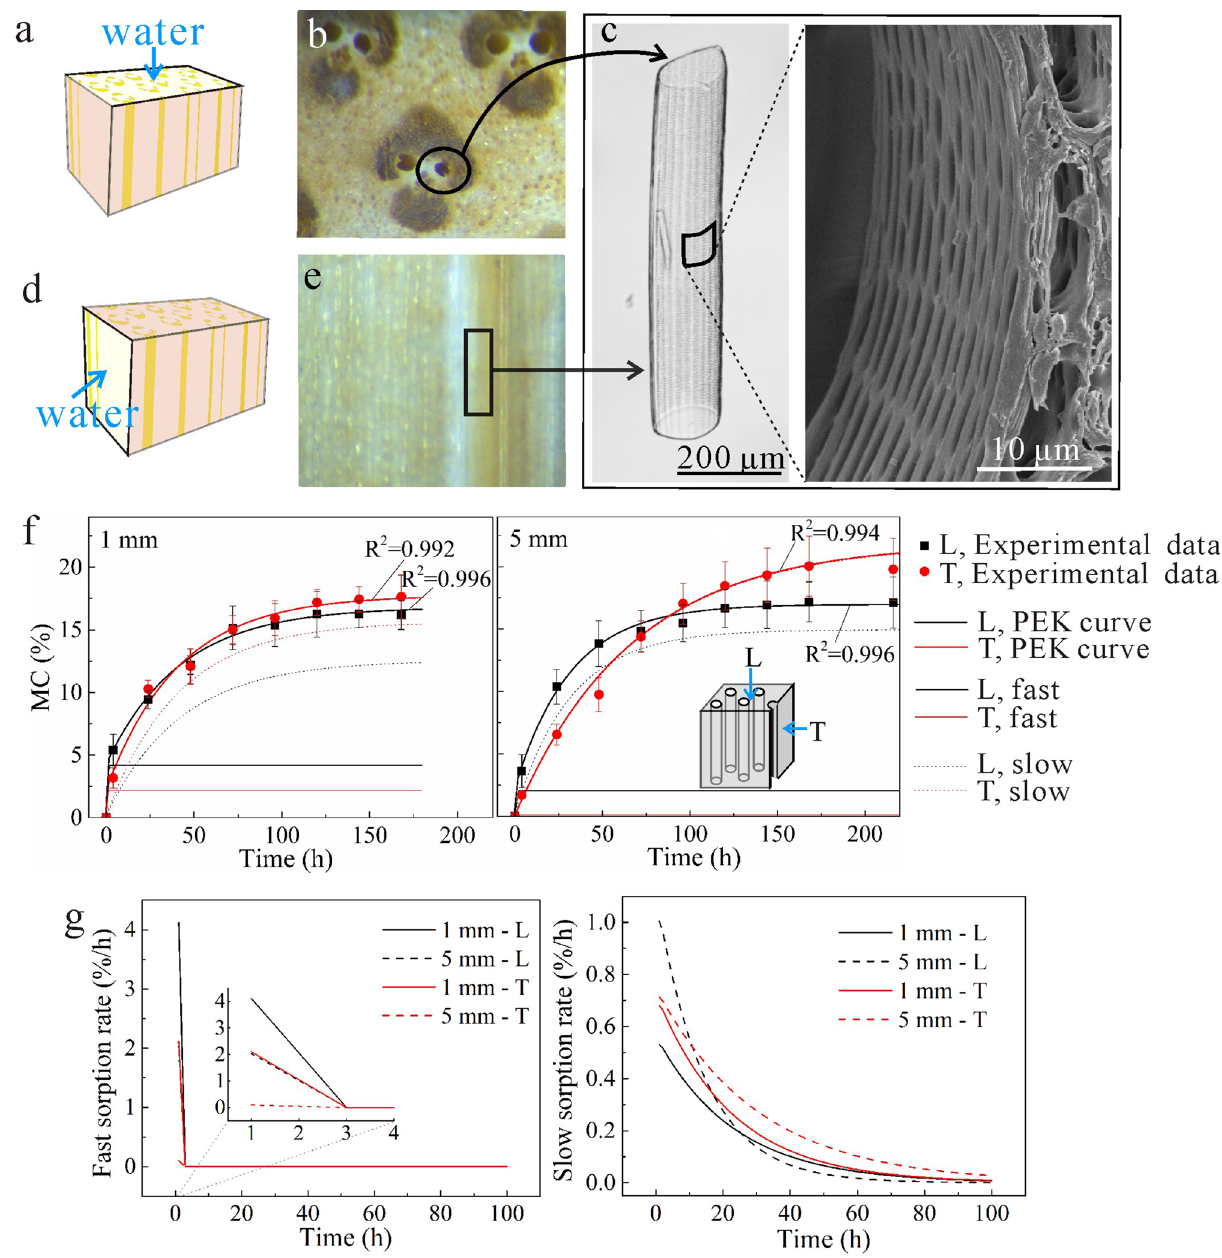
Figure 5. ( a , b ) Structural characterization of 5 mm specimen with longitudinal sorption direction: ( a ) Graphical illustration of specimen, ( b ) Optical micrograph pictures of sorption surface. ( c ) The front view of a single vessel cell and top view of vessel cell in specimens. ( d , e ) Structural characterization of 5 mm specimen with transverse sorption direction: ( d ) Graphical illustration of specimen, ( e ) Optical micrograph pictures of parenchyma cells. ( f , g ) Sorption behaviors of bamboo block (1 and 5 mm) with different sorption directions (T and L): ( f ) experimental data (dots) of MC over time by the saturated salt solution method, PEK fitted curves (lines),and slow and fast processes of PEK model, ( g ) sorption rates of fast (left) and slow (right) wall substance, the effect of pits, and the water vapor diffusion in the cell lumen to account for the total sorption behavior. The MC values with error bars for bamboo blocks with two thicknesses (1 and 5 mm) and two sorp- tion directions are shown as dots in Fig. 5f. During the initial sorption period, MC of L specimens was higher than that of T specimens, while contradictory results were obtained after a certain period of time, i.e., 24 h for 1 mm and 100 h for 5 mm. These were caused by the vessel cells. Vessel cells had big lumens and thin cell walls with many pits and most of the vessel cells had open ends (Fig. 5c). The water–vapor diffusion coefficient in cell lumen was much higher than the bound-water diffusion coefficient in cell wall 27 . For the L specimens (Fig. 5b), water could access the inside of the vessel cell lumen through its end surfaces, and then into bamboo cell wall through the pits in the lumen cell wall (Fig. 5c). However, for the T specimen (Fig. 5e), water could only access